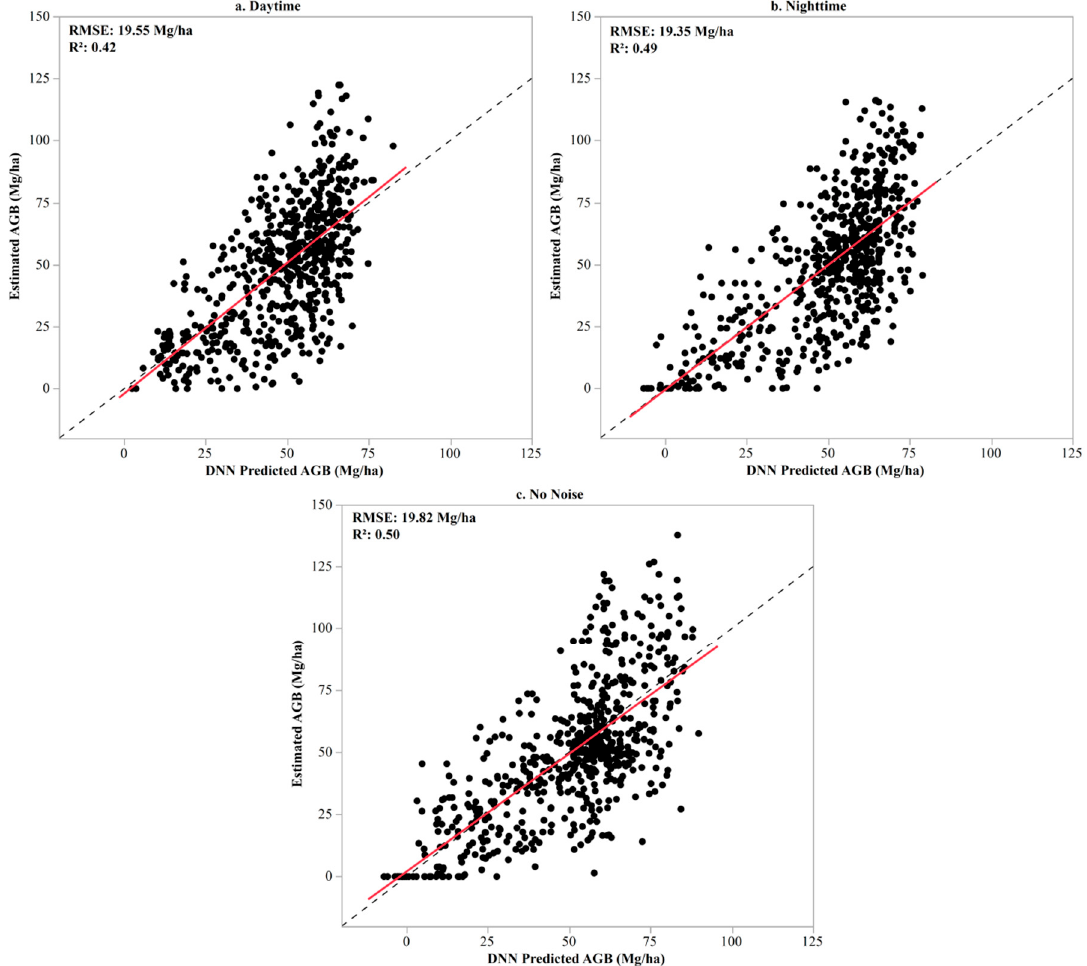
Figure 5. ( a ) Simulated PCL AGB estimated from linear regression vs DNN predicted AGB with test data for the daytime scenario; ( b ) Simulated PCL AGB estimated from linear regression vs DNN predicted AGB with test data for the nighttime scenario ( c ) Simulated PCL AGB estimated from linear regression vs DNN predicted AGB with test data for the no noise scenario. The dashed line in each graph is the 1:1 line.